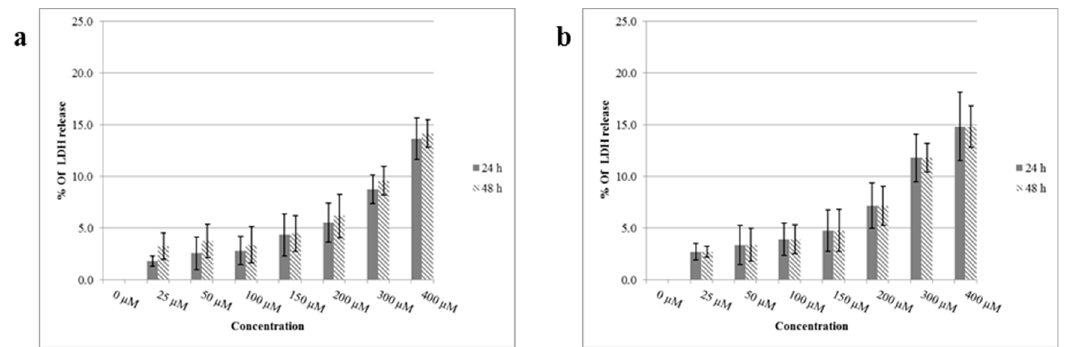
Figure 4. Lactate dehydrogenase (LDH) results after 24 and 48 h treatment of bEnd.3 cells with: ( a ) G0K-FP and ( b ) G1K-FP. The absorbance was measured and the LDH release of each was calculated as a percentage of absorbance in relation to untreated, complete lysis control cells with significantly different to the positive control ( p < 0.001). The data represent mean ± SD of n = 6.